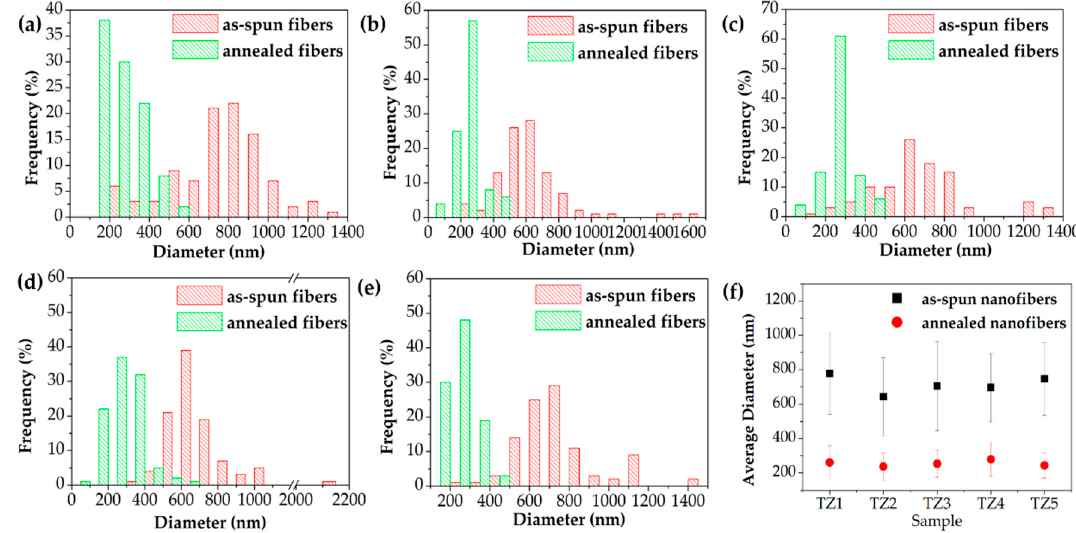
Figure 4. Diameter histogram of as-spun, annealed Ti–Zn complex oxide nanofibers (( a ): TZ1, ( b ): TZ2, ( c ): TZ3, ( d ): TZ4 and ( e ): TZ5) and the average diameters ( f ) with different molar ratios of Ti and Zn.